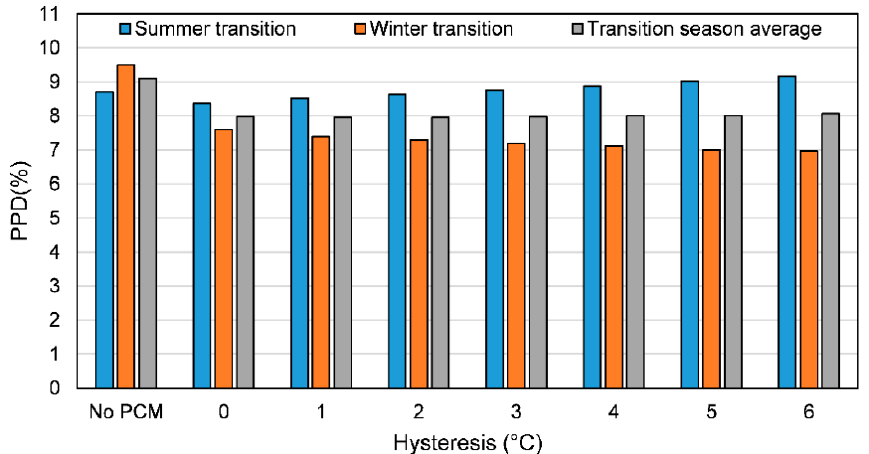
Figure 15. The predicted percentage of dissatisfied (PPD) of the cases using PCM with different hysteresis degrees in transition seasons.